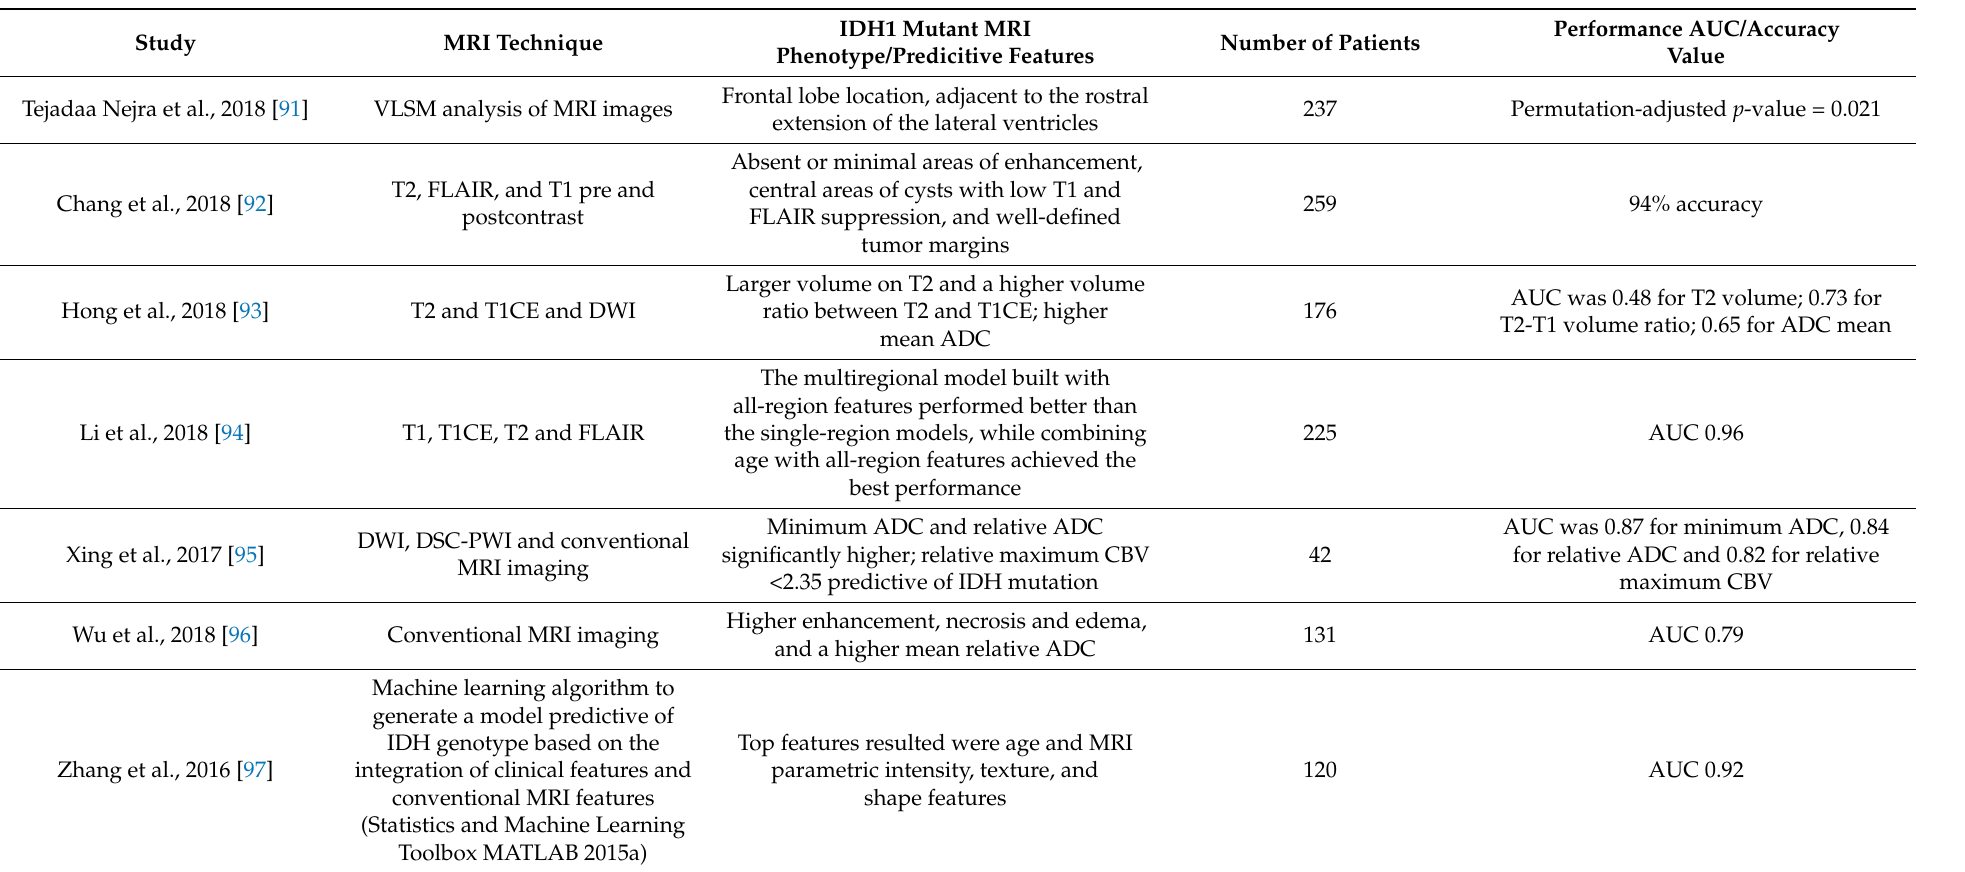
Table 1. Relevant radiogenomic studies predicting IDH mutational